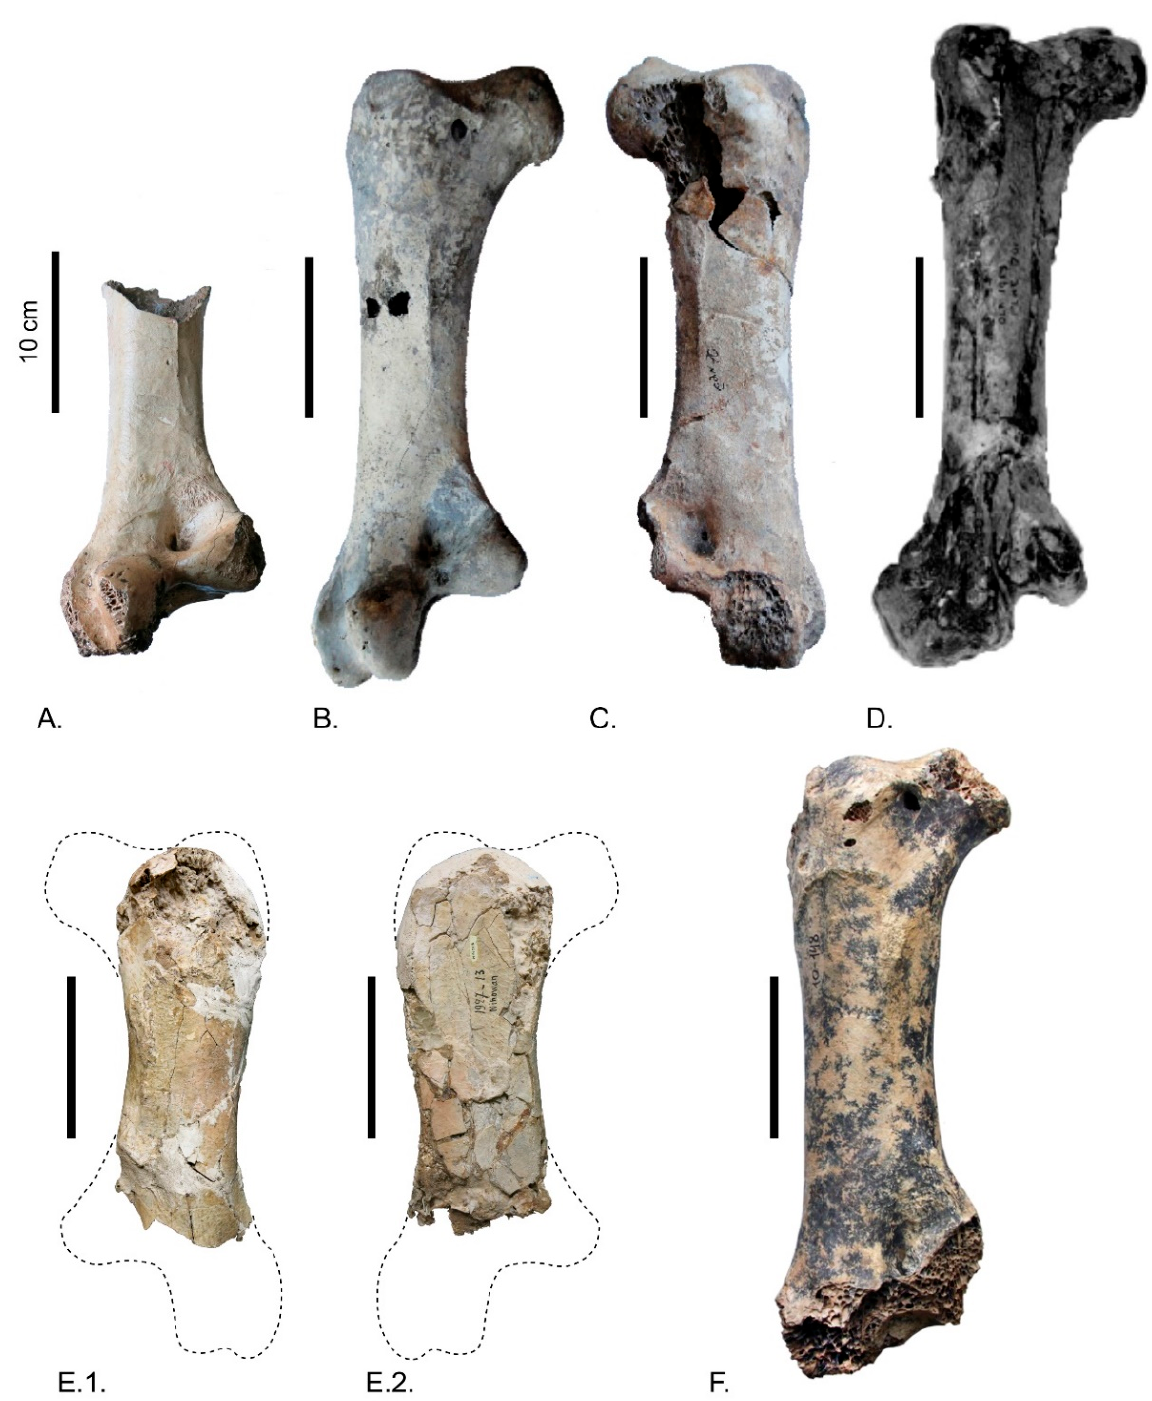
Figure 4. Comparison of the femur MNHN–NIH008 with other femora of Pleistocene ostriches. ( A ) Femur of Struthio anderssoni , from Zhoukoudian (China), specimen number IVPP V6943, in caudal view. ( B ) Femur of Pachystruthio cf. dmanisensis ), from Dmanisi (Georgia), specimen number D5768, in cranial view (from [22]). ( C ) Femur of Pachystruthio cf. dmanisensis ), from Dmanisi (Georgia), specimen number D70, in caudal view (from [22]). ( D ) Femur of Struthio oldawayi , from Olduvai (Tanzania), in cranial view (from [20]); E: femur of giant ostrich ( Pachystruthio indet .), specimen number MNHN–NIH008, from the Lower Pleistocene of the Nihewan Basin, northern China, in caudal ( E.1 ) and cranial ( E.2 ) views. ( F ) Femur of Pachystruthio cf. dmanisensis , from Taurida Cave (Crimea), specimen number PIN 5644/56, in caudal view (from [23]).